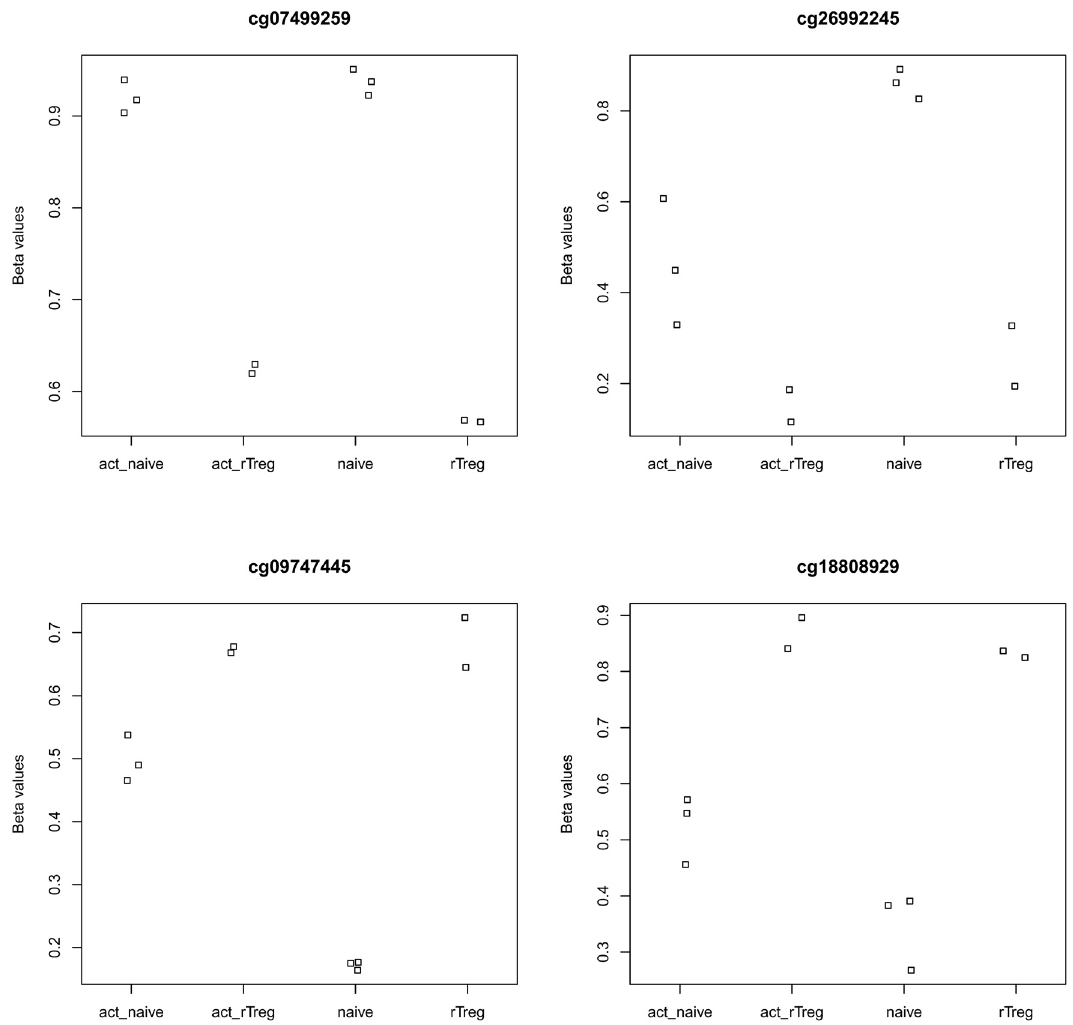
Figure 9. Plotting the top few differentially methylated CpGs is a good way to check whether the results make